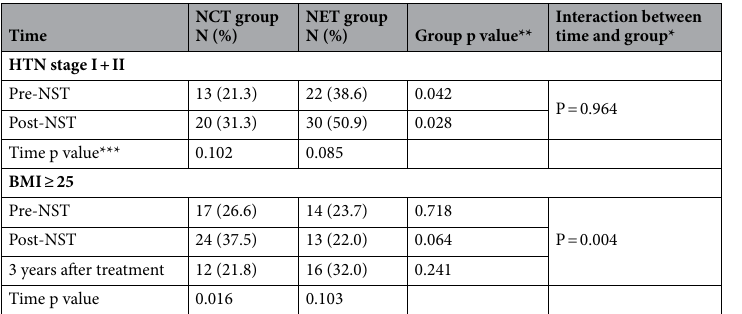
Table 3. Changes in hypertension and Obese group. HTN Hypertension, BMI Body mass index, NST Neoadjuvant systemic treatment, NCT Neoadjuvant chemotherapy, NET Neoadjuvant endocrine therapy. *Indicates a significant difference between NCT and NET groups in changes over time. **Comparison between two groups by specific time. ***Significance of changes over time for each group.